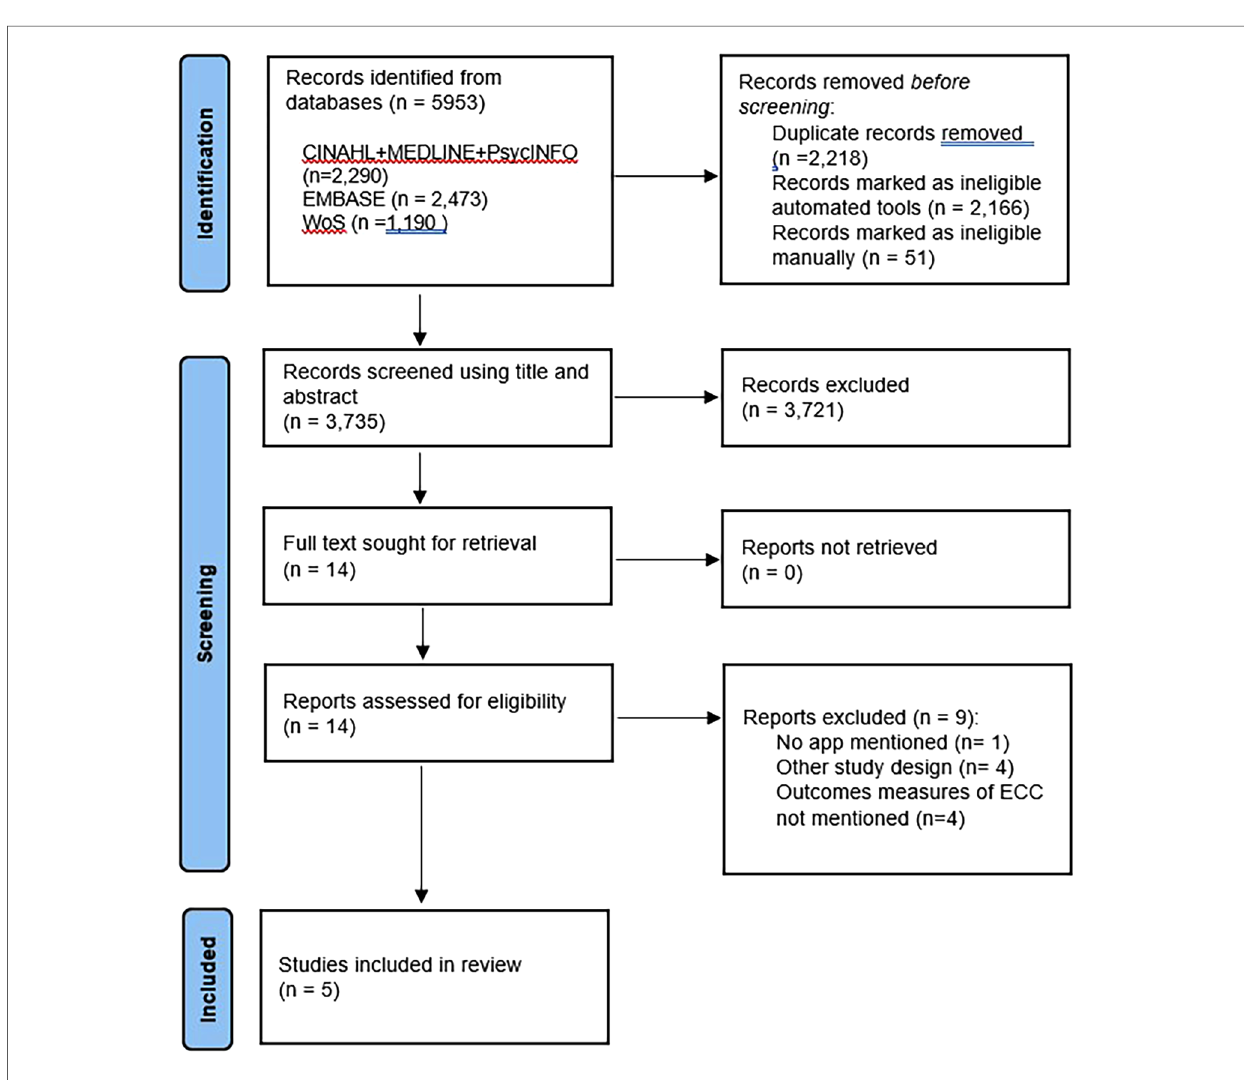
FIGURE 1 PRISMA fl ow